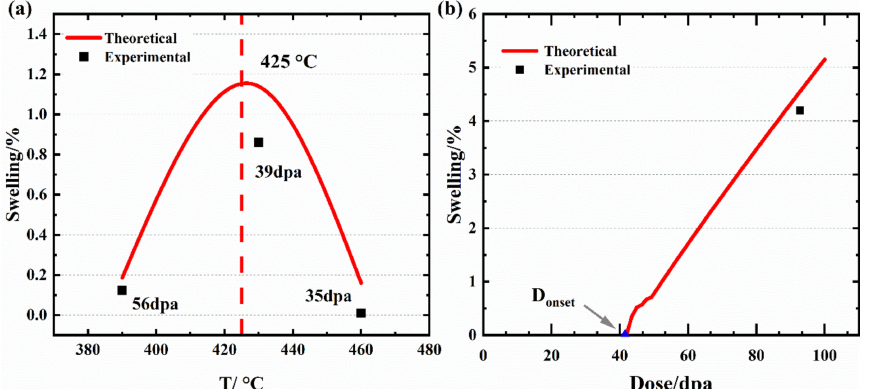
Figure 5. Neutron irradiation swelling of F/M steels: ( a ) swelling as a function of temperature in JLF-1 with an irradiation dose of 60 dpa, ( b ) swelling as a function of the dose at 425 ◦ C in Fe-9Cr binary alloy where the black squares represent experimental data from